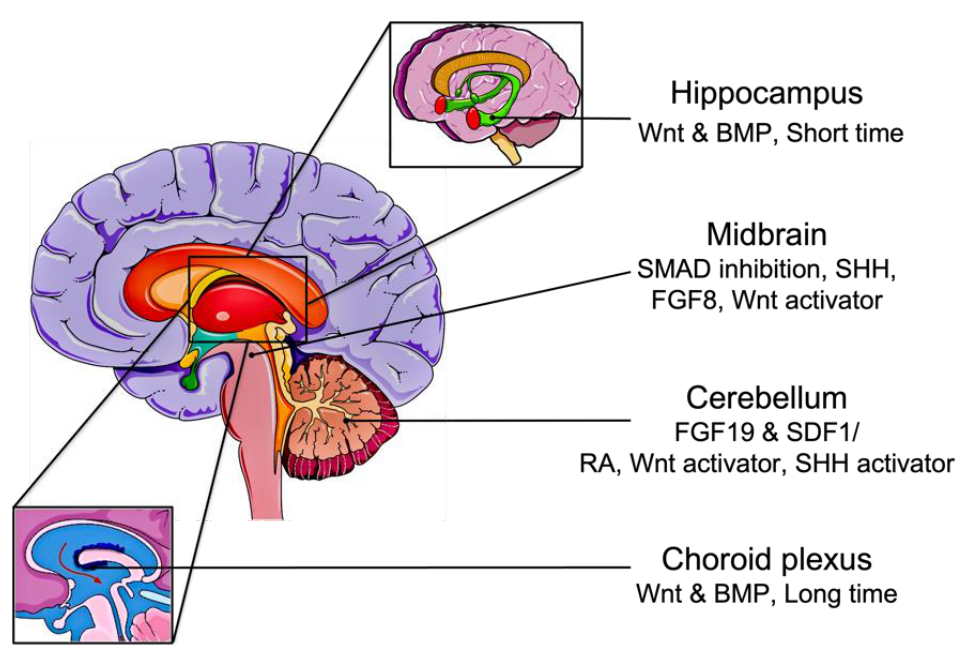
Figure 2. Brain organoid differentiation from iPSCs. The addition of RA, Wnt, and SHH activators generates cerebellar organoids directly from iPSCs. Pluripotent stem cells can be differentiated into cerebellar tissue through FGF19 and SDF1 treatment. Induced PSCs aggregate into embryoid bodies in serum-free suspension. Short-term treatment of Wnt and BMP to EBs develops hippocampus organoids, while long-term treatment generates choroid plexus organoids. If treated with FGF19 and SDF1, EBs can form cerebellum